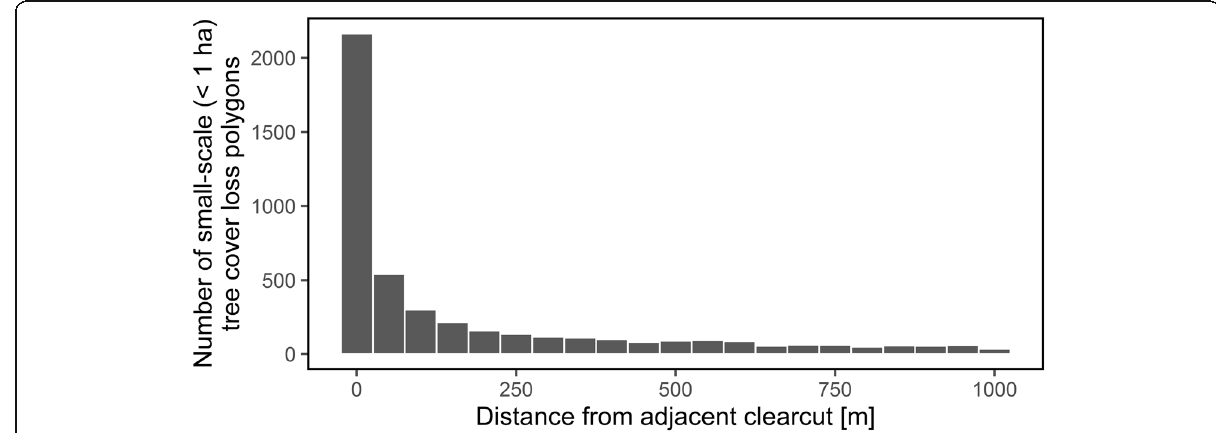
Fig. 3 Relationship between small- and large-scale tree cover loss in the sample area